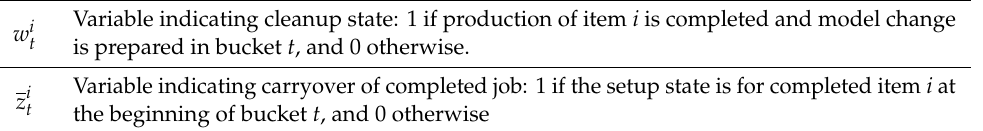
Table 7. New variables for M2.